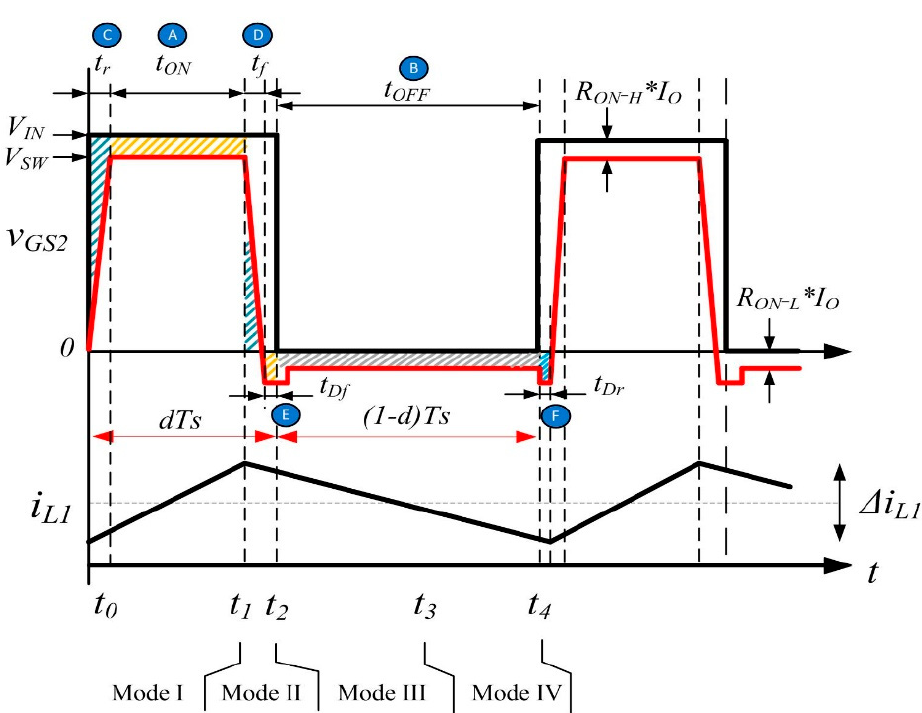
Figure 16. Switching waveforms and power loss areas.